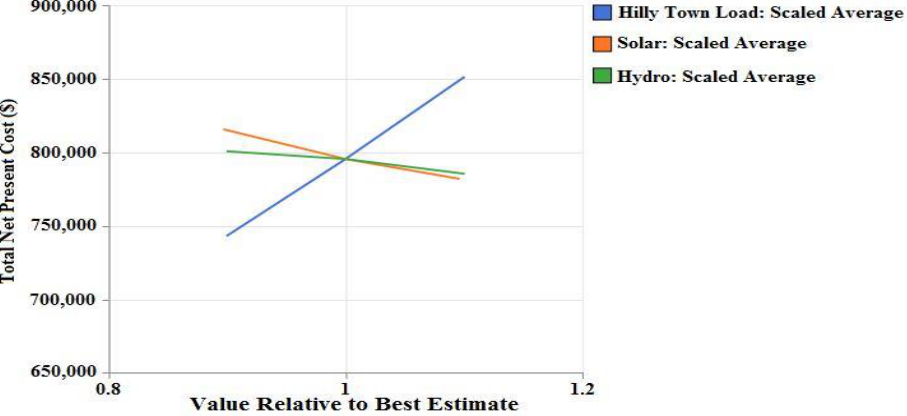
Figure 33. Spider-type plot showing scaled sensitive variables of hydro, load and solar.